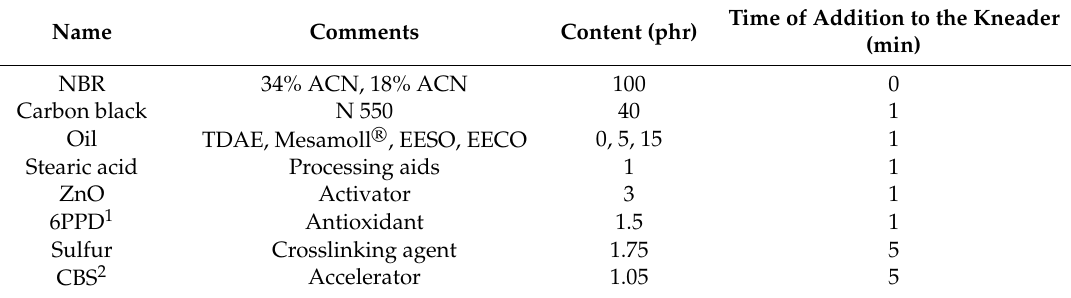
Table 1. Composition and time of addition during